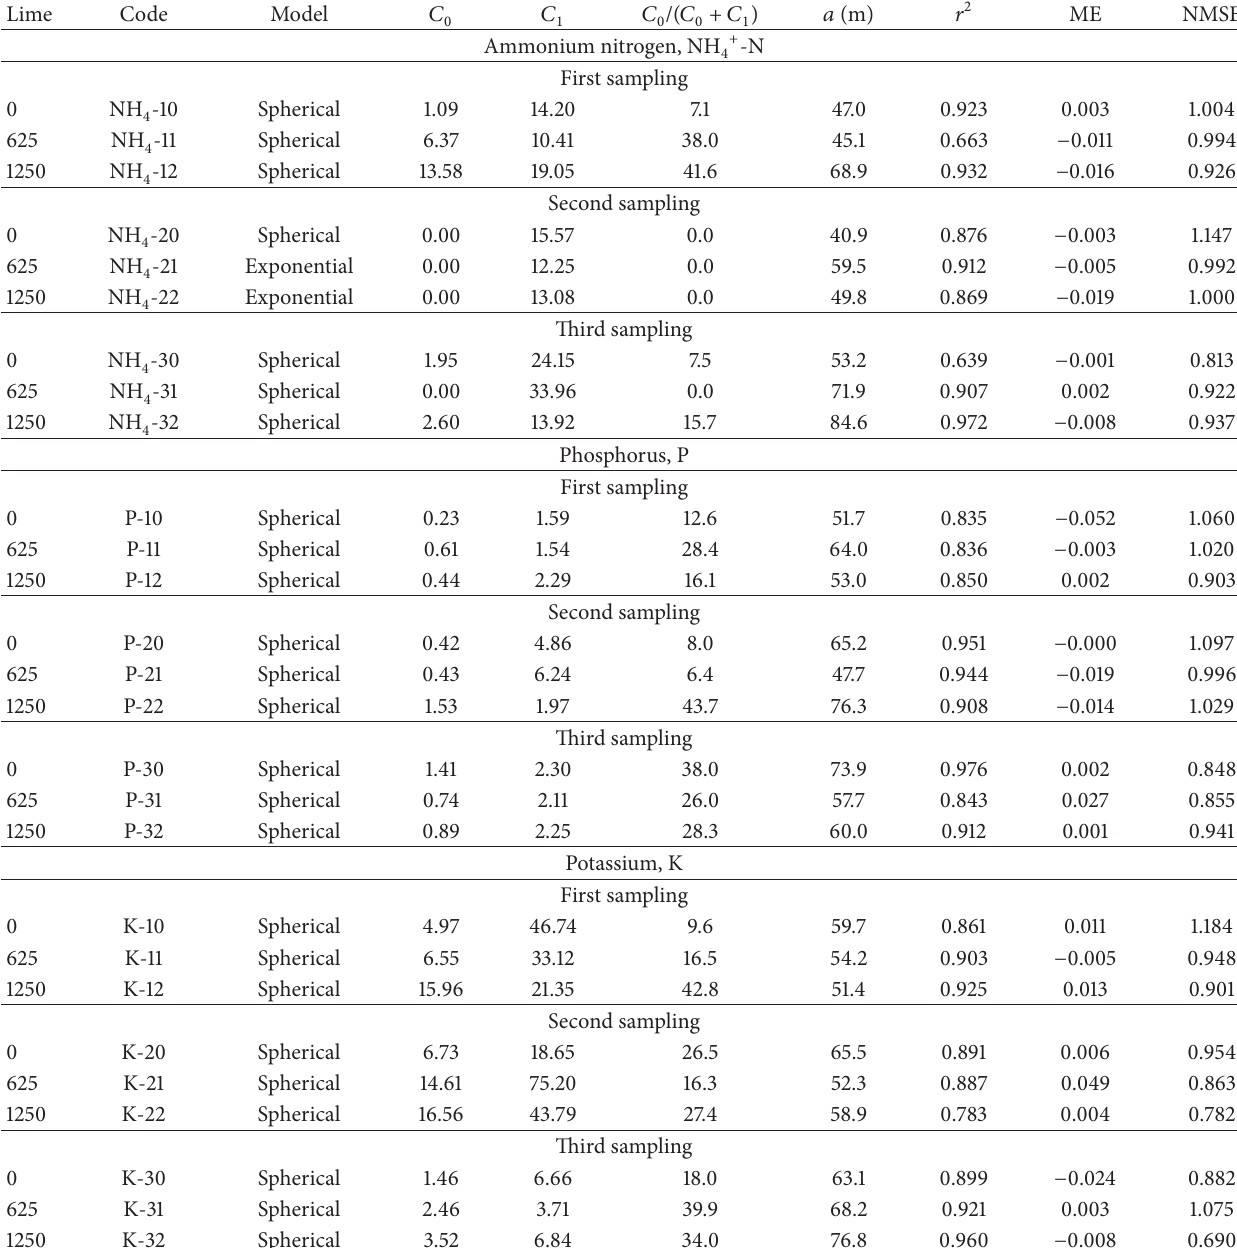
-N, P, and K data 4